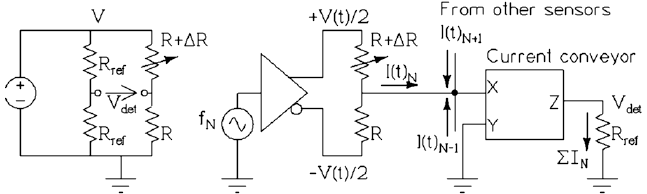
Figure 1. Concept of the standard Wheatstone bridge ( left ) and the described differential AC driven, current summed architecture ( right ).